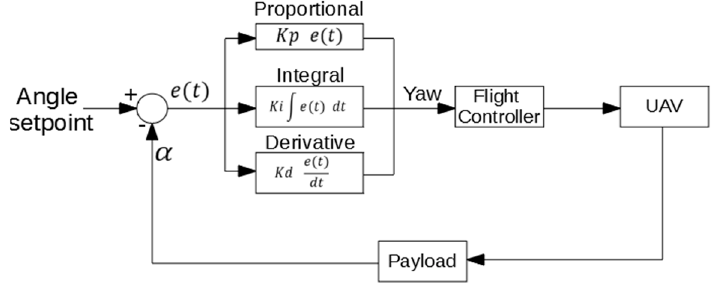
Figure 8. PID algorithm for the angular control.